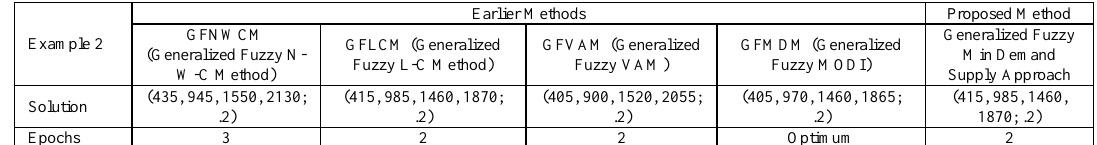
Table 10. Comparison based on optimal solution and epochs (Example